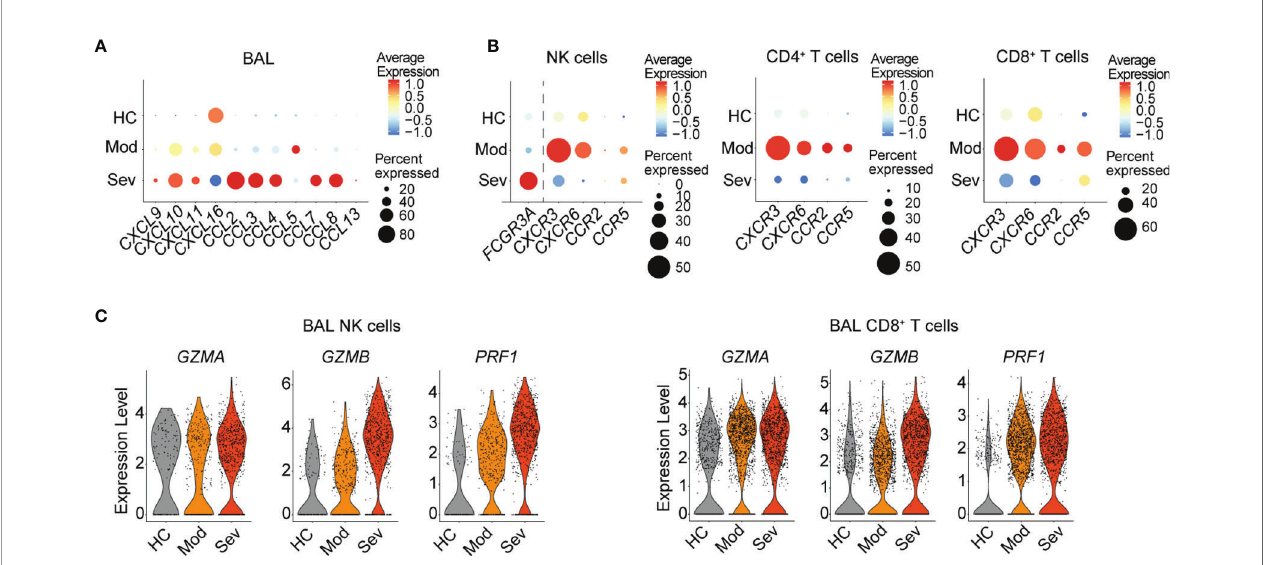
FIGURE 4 | Gene expression of chemokines, chemokine receptors, and effector molecules in NK cells and T cells in BAL fl uid in patients with moderate and severe COVID-19. (A) Dot plots of average chemokine RNA expression in total BAL fl uid cells. (B) Average gene expression and proportion of FCGR3A and chemokine receptors in NK cells as well as chemokine receptors in CD4 + and CD8 + T cells from BAL fl uid from healthy controls ( n = 3) and COVID-19 patients with moderate ( n = 3) or severe ( n = 6) disease. (C) Violin plots of RNA expression of effector molecules in BAL fl uid NK cells and in CD8 + T cells in healthy controls and moderate and severe COVID-19 patients. (A – C) The respective scRNA-seq dataset is derived from Liao et al.